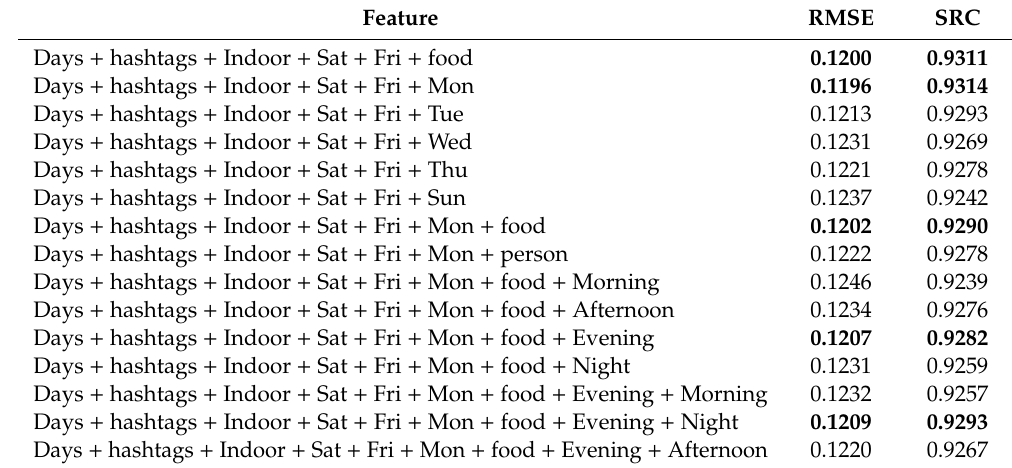
Table 7. Comparison of Likes prediction using XGBoost tree method with specific feature